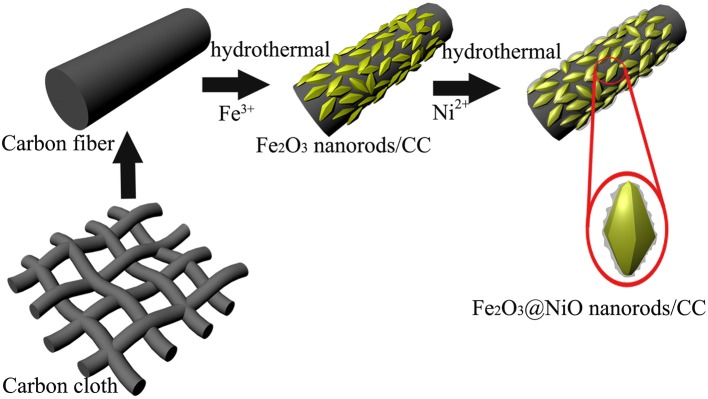
The schematic diagram of the growth process for Fe2O3@NiO/CC.